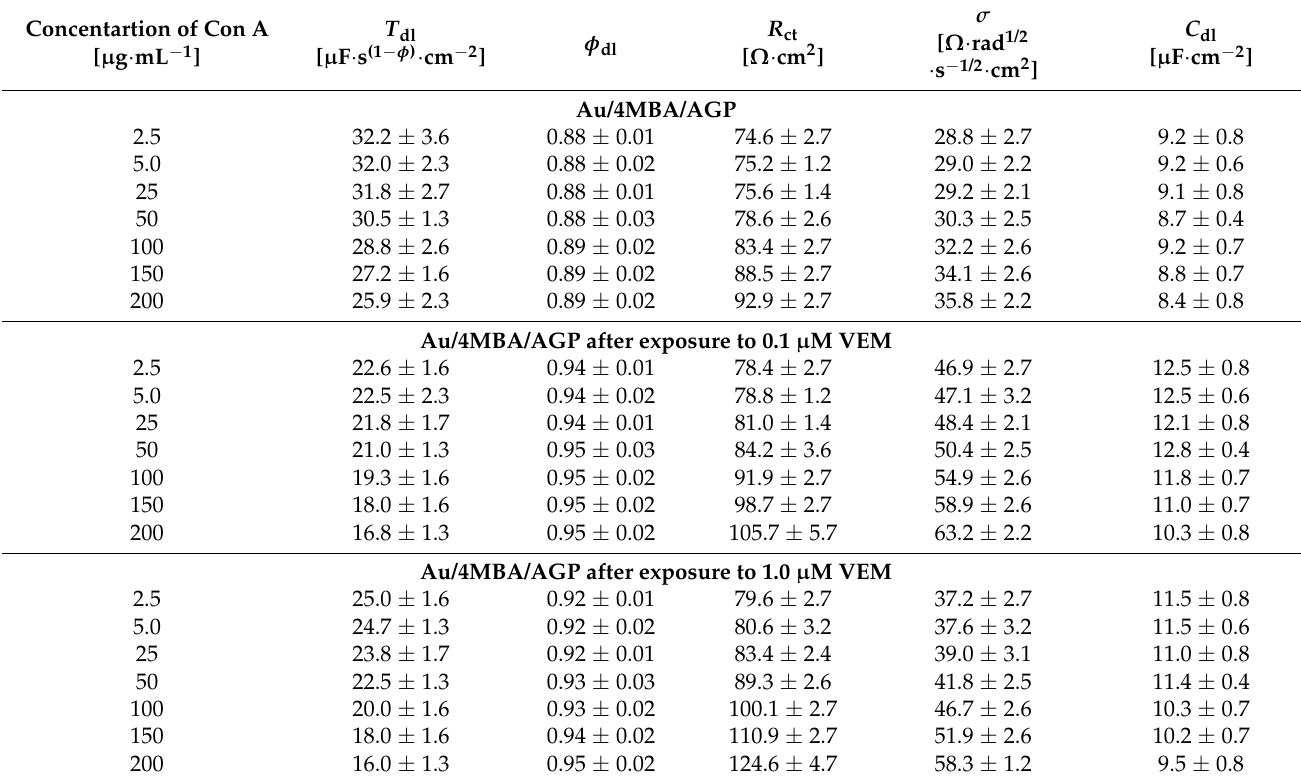
Table 3. EIS parameters ( n = 3) (capacitive parameter- T dl and exponential factor- φ dl of the constant phase element (CPE); charge transfer resistance- R ct ), Warburg parameter- σ , and double layer capacity- C dl ) for each step of electrode modification and Con A